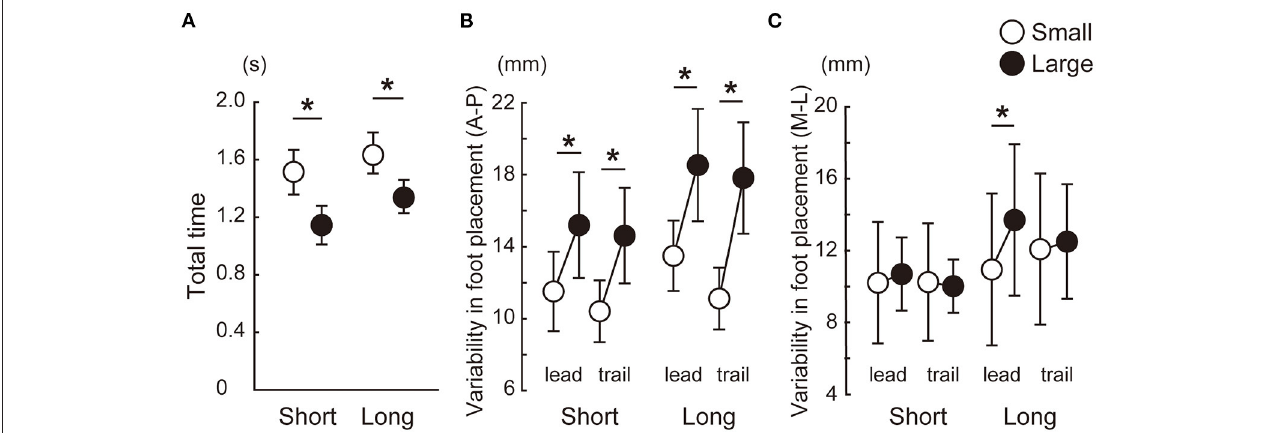
FIGURE 3 | Speed-accuracy tradeoff in the forward stepping task in which participants pointed at targets with their great toes. Between-participant means and standard deviations are shown. The total step time was longer in the small target condition than in the large target condition (A) . The foot placement error was smaller in the small target conditions than in the large target conditions in both the anteroposterior axis (B) and mediolateral axis (C) . *Significant difference between the small and large target conditions ( p < 0.025).